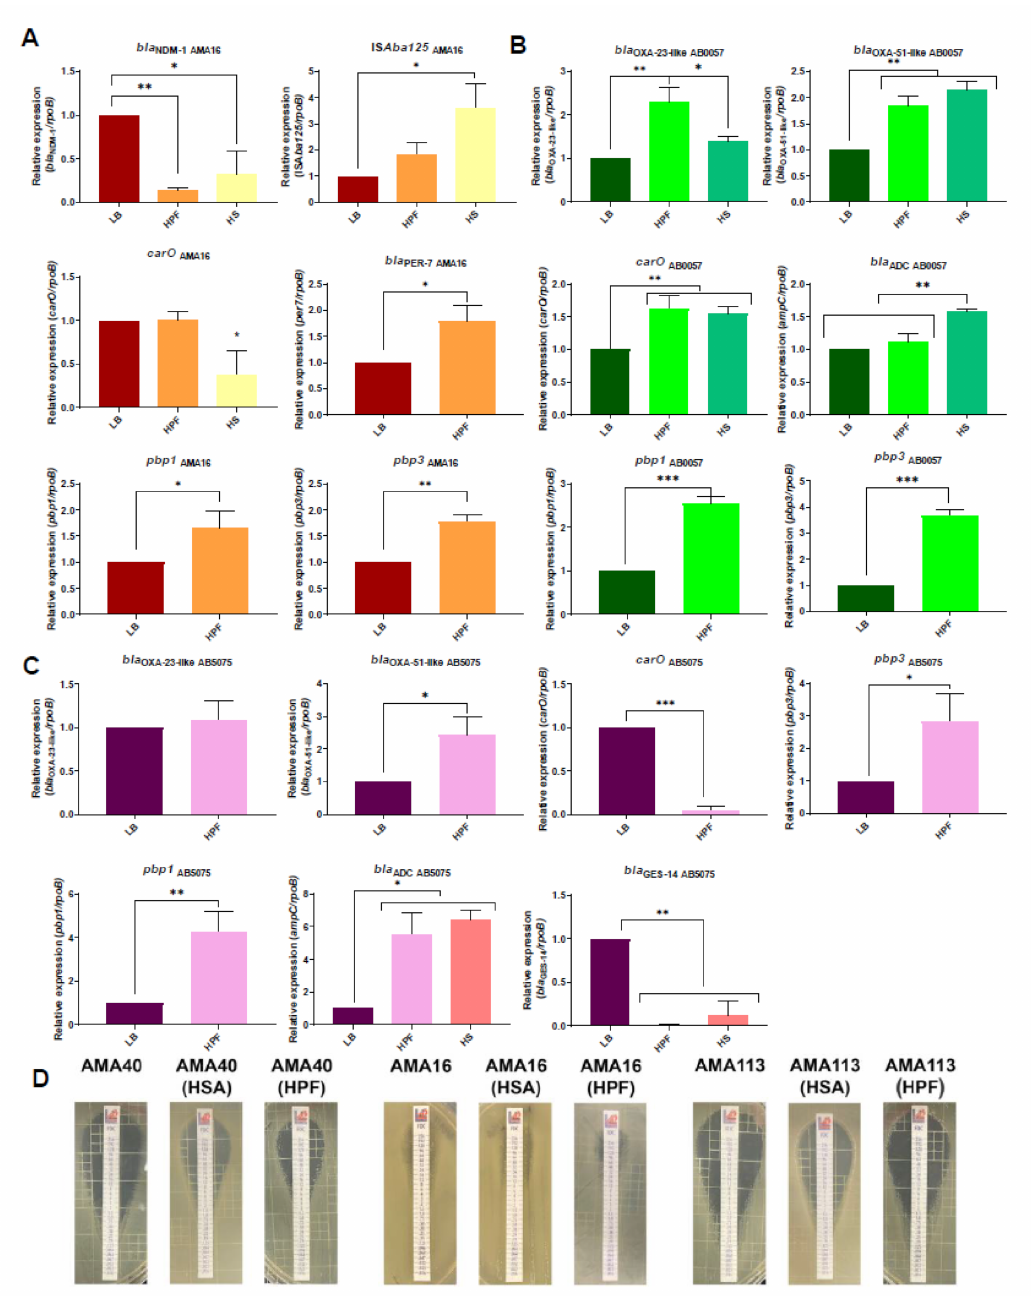
Figure 2. ( A – C ) Genetic analysis of β -lactamase and PBP genes of AMA16 ( A ), AB0057 ( B ), and AB5075 ( C ) A. baumannii strains and qRT-PCR of genes associated with β -lactams resistance expressed in LB, LB supplemented with HPF, or in HS. Fold changes were calculated using double ∆ Ct analysis. At least three independent samples were used. LB was used as the reference condition. Statistical significance ( p < 0.05) was determined by ANOVA followed by Tukey’s multiple comparison test: one asterisk: p < 0.05; two asterisks: p < 0.01; and three asterisks: p < 0.001. ( D ) Effect of HSA and HPF on the antimicrobial susceptibility of A. baumannii representative strains AMA40 and AMA113 grown in LB broth, LB broth plus 3.5% HSA, or HPF, that were used to perform cefiderocol (CFDC) susceptibility. Minimum inhibitory concentration (MIC) on cation-adjusted Mueller–Hinton agar was performed by MTS (Liofilchem S.r.l., 64026 Roseto degli Abruzzi TE, Italy), following the manufacturer’s